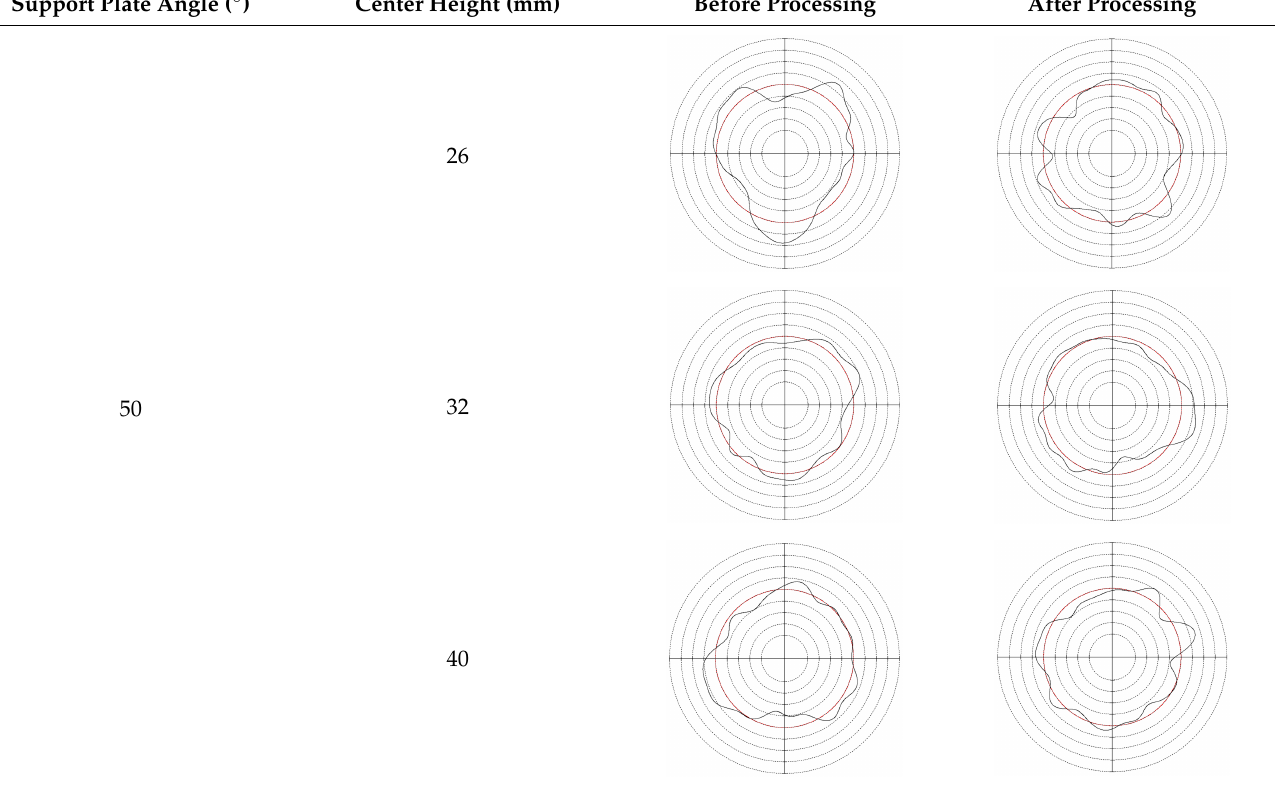
balanced, which is conducive to stable processing and obtaining multiple-lobe profiles. Table 5. Profile shapes before and after processing at different support plate angles and center Table 5. Profile shapes before and after processing at different support plate angles and center Table 5. Profile shapes before and after processing at different support plate angles and center Table 5. Profile shapes before and after processing at different support plate angles and center Table 5. Profile shapes before and after processing at different support plate angles and center Table 5. Profile shapes before and after processing at different support plate angles and center Table 5. Profile shapes before and after processing at different support plate angles and center heights. heights. heights. heights. heights. heights.